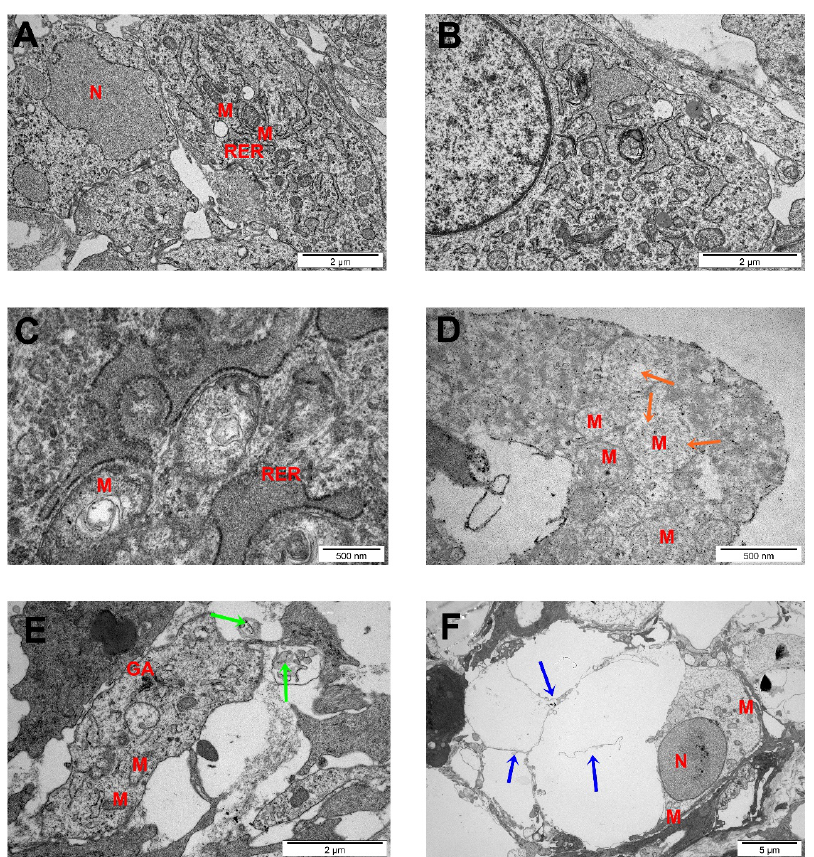
Figure 7. Glioblastoma multiforme tumors ultrastructure from control group ( A , B ) after